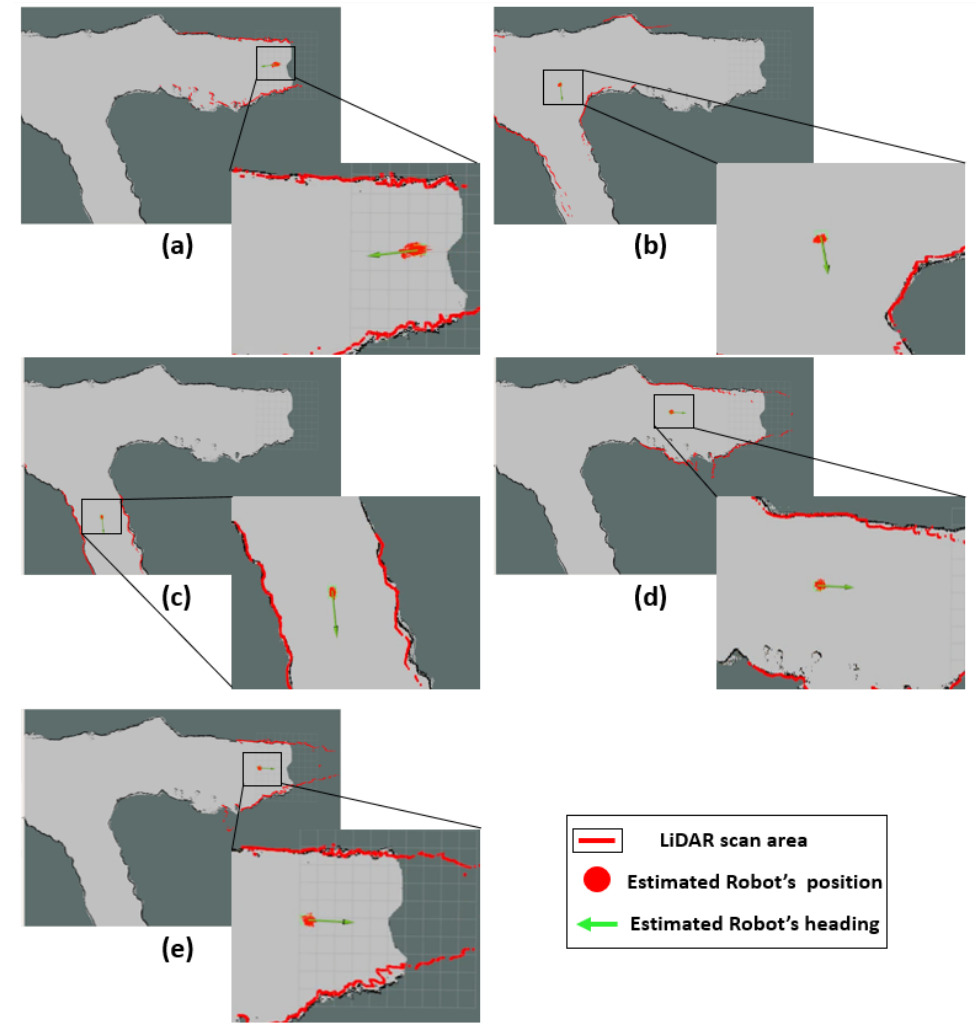
Figure 11. View of the robot’s heading, position, and LiDAR data at the ( a ) starting point, ( b ) inter- section, ( c ) destination, ( d ) returning area, and ( e ) arrival point.